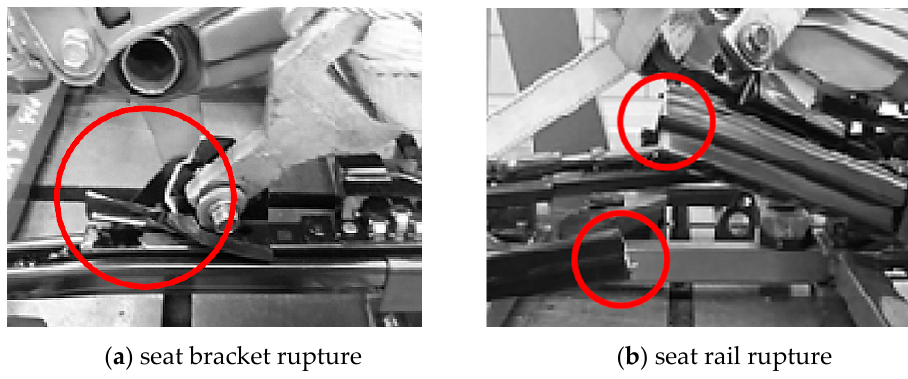
Figure 2. Failure cases of seat belt anchorage test without vehicle [14].